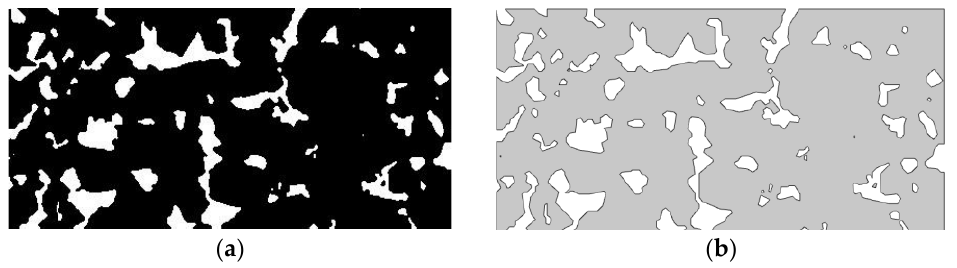
Figure 9. Image import: ( a ) Cross-sectional view; ( b ) Model establishment.